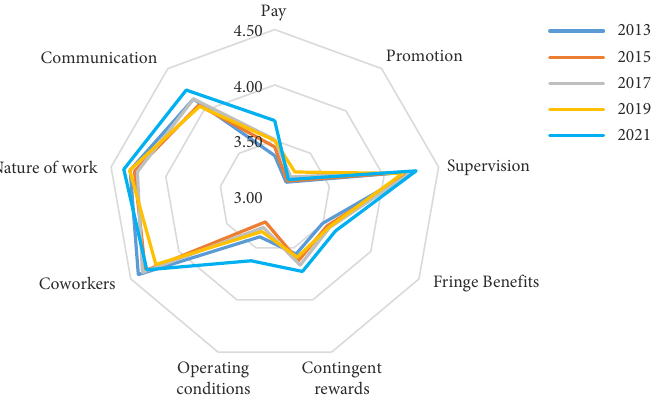
Figure 2. Average job satisfaction for males from 2013 to 2021 (source: own processing)